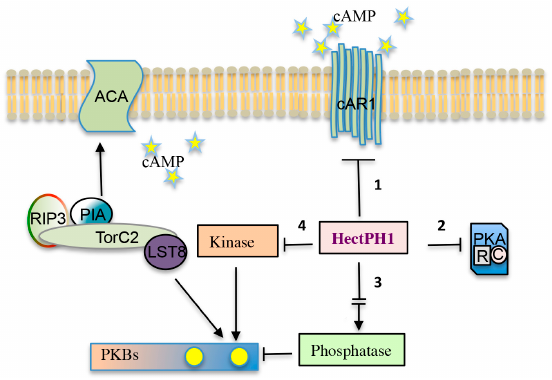
Figure 4. Model of the putative HectPH1 ubiquitin targets in cAMP signalling. Solid arrows and T-bars symbolize positive and negative regulatory loops, respectively. The broken arrow indicates an indirect activation because likely mediated by unknown factor/s.